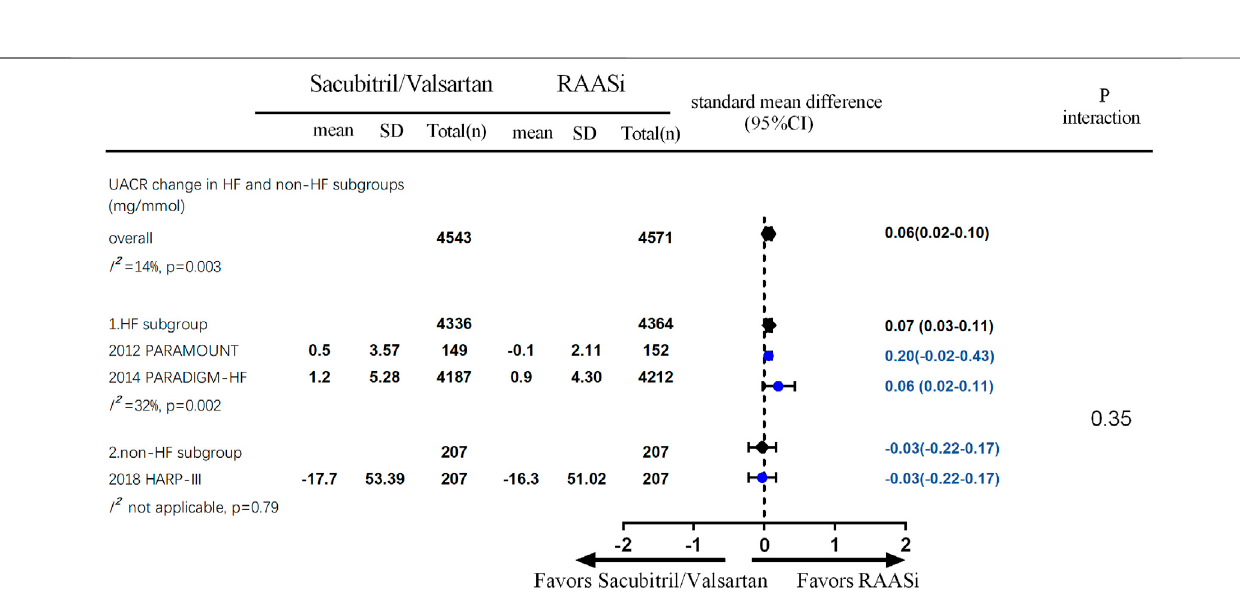
Frontiers in Pharmacology |